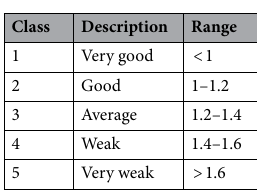
Table 10. Classification of vegetation quality index (VQI).